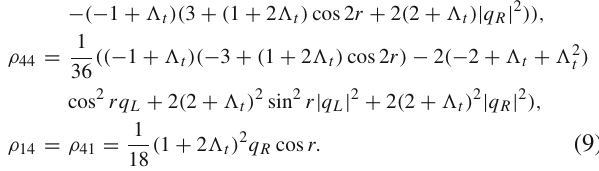
Fig. 3 QSLT for a given two-qubit state, quantified by τ QSL /τ as a function of the acceleration parameter r , when both Alice and Bob’s state are in the DPC. We set q R = 1 − ( − 1 + (cid:16) )( 3 + ( 1 + 2 (cid:16) ) cos2 r + 2 ( 2 + (cid:16) ) | q | 2 t t t R